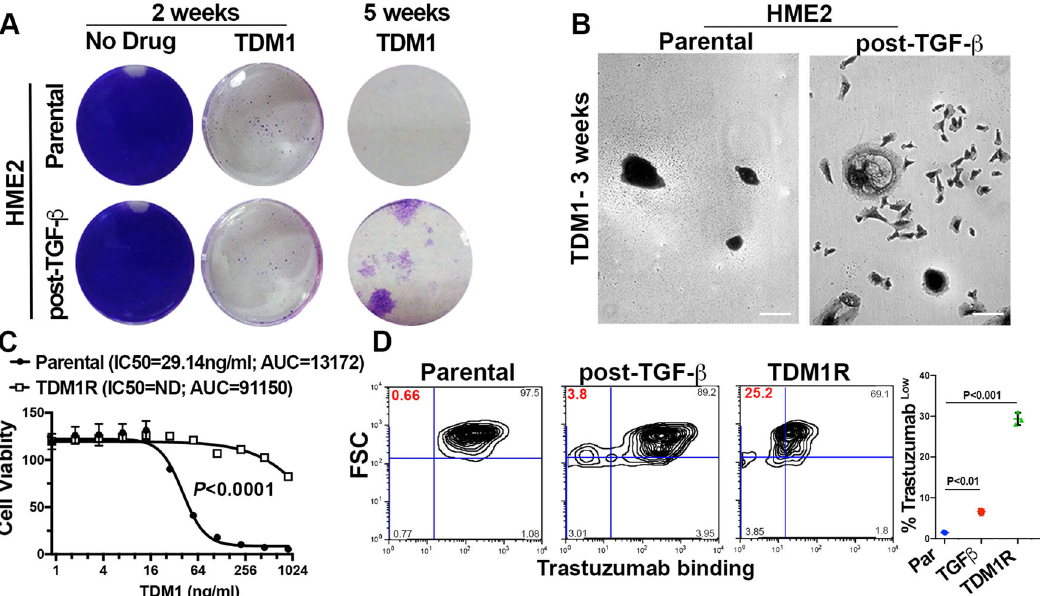
Fig. 2 In vitro establishment of T-DM1-resistant cells requires prior induction of epithelial – mesenchymal transition. A HME2 cells were left untreated (parental) or were stimulated with TGF- β 1 and allowed to recover (post-TGF- β ) as described in the “ Materials and methods ” . These two cell populations were subsequently treated with T-DM1 (250 ng/ml) every 3 days for a period of 5 weeks. Representative wells were stained with crystal violet at the indicated time points to visualize viable cells. B Bright fi eld microscopy of crystal-violet-stained HME2 parental and post-TGF- β cells following 3 weeks of continuous T-DM1 treatment. C The T-DM1-resistant (TDM1R) cells that survived 5 weeks of treatment were further expanded and cultured for a period of 4 weeks in the absence of T-DM1. These cells along with passage-matched parental HME2 cells were subjected 96 h treatments with the indicated concentrations of T-DM1 and assayed for cell viability. Data are the mean ± SE of three independent experiments resulting in the indicated P value. D Parental, post-TGF- β , and TDM1R HME2 cells were stained with Alexa fl uor 647-labeled trastuzumab and antibody binding was quanti fi ed by fl ow cytometry. The percentage of cells in each quadrant with reference to forward scatter (FSC) is indicated. Also shown is the mean, ±SD, percentages of low trastuzumab binding (Trastuzumab Low ) cells of three independent experiments resulting in the indicated P